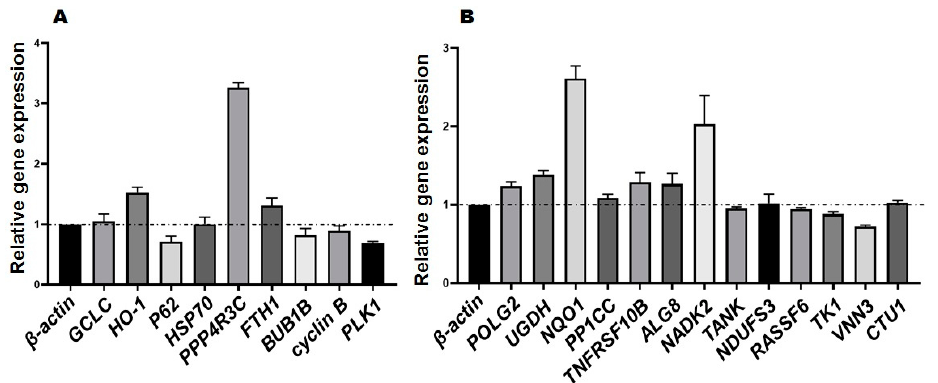
Figure 4. Relative gene expression: ( A ) genes coded differential proteins screened from ferroptosis